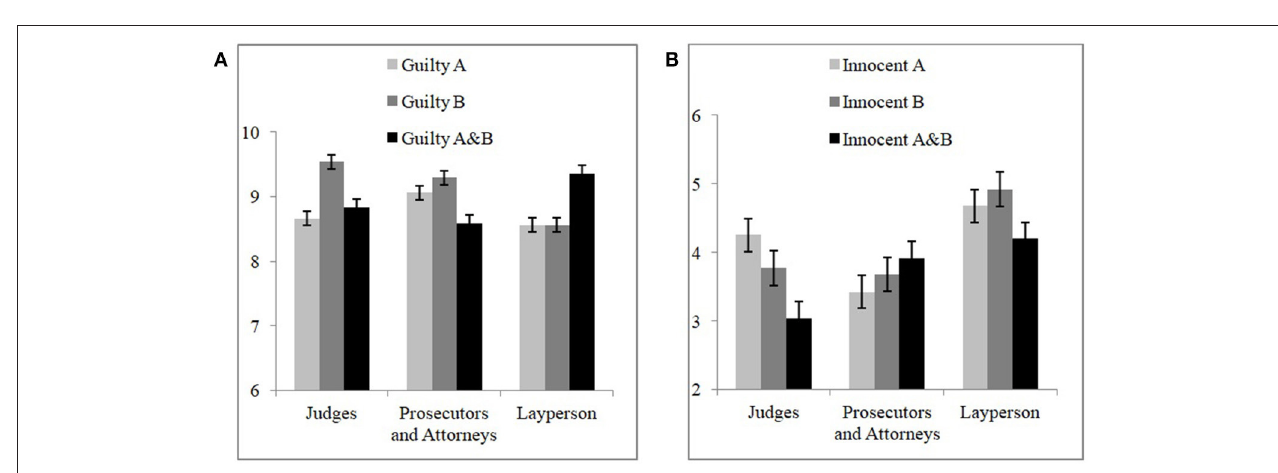
FIGURE 2 | CF and guilt probability ratings by different professional groups of (A) guilty suspects’ cases and (B) innocent suspects’ cases (on a 1 to 10 points scale), bars represent standard error of the